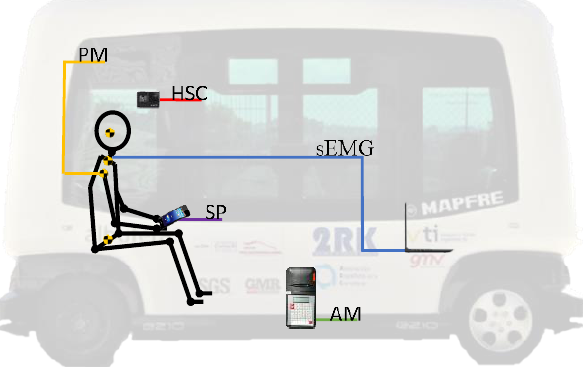
Figure 5. Devices built in to perform the experiment. PM: Position Markers, HSC: High-Speed Camera, SP: Smartphone, AM: Accelerometer, sEMG: sensors of surface electromyography.